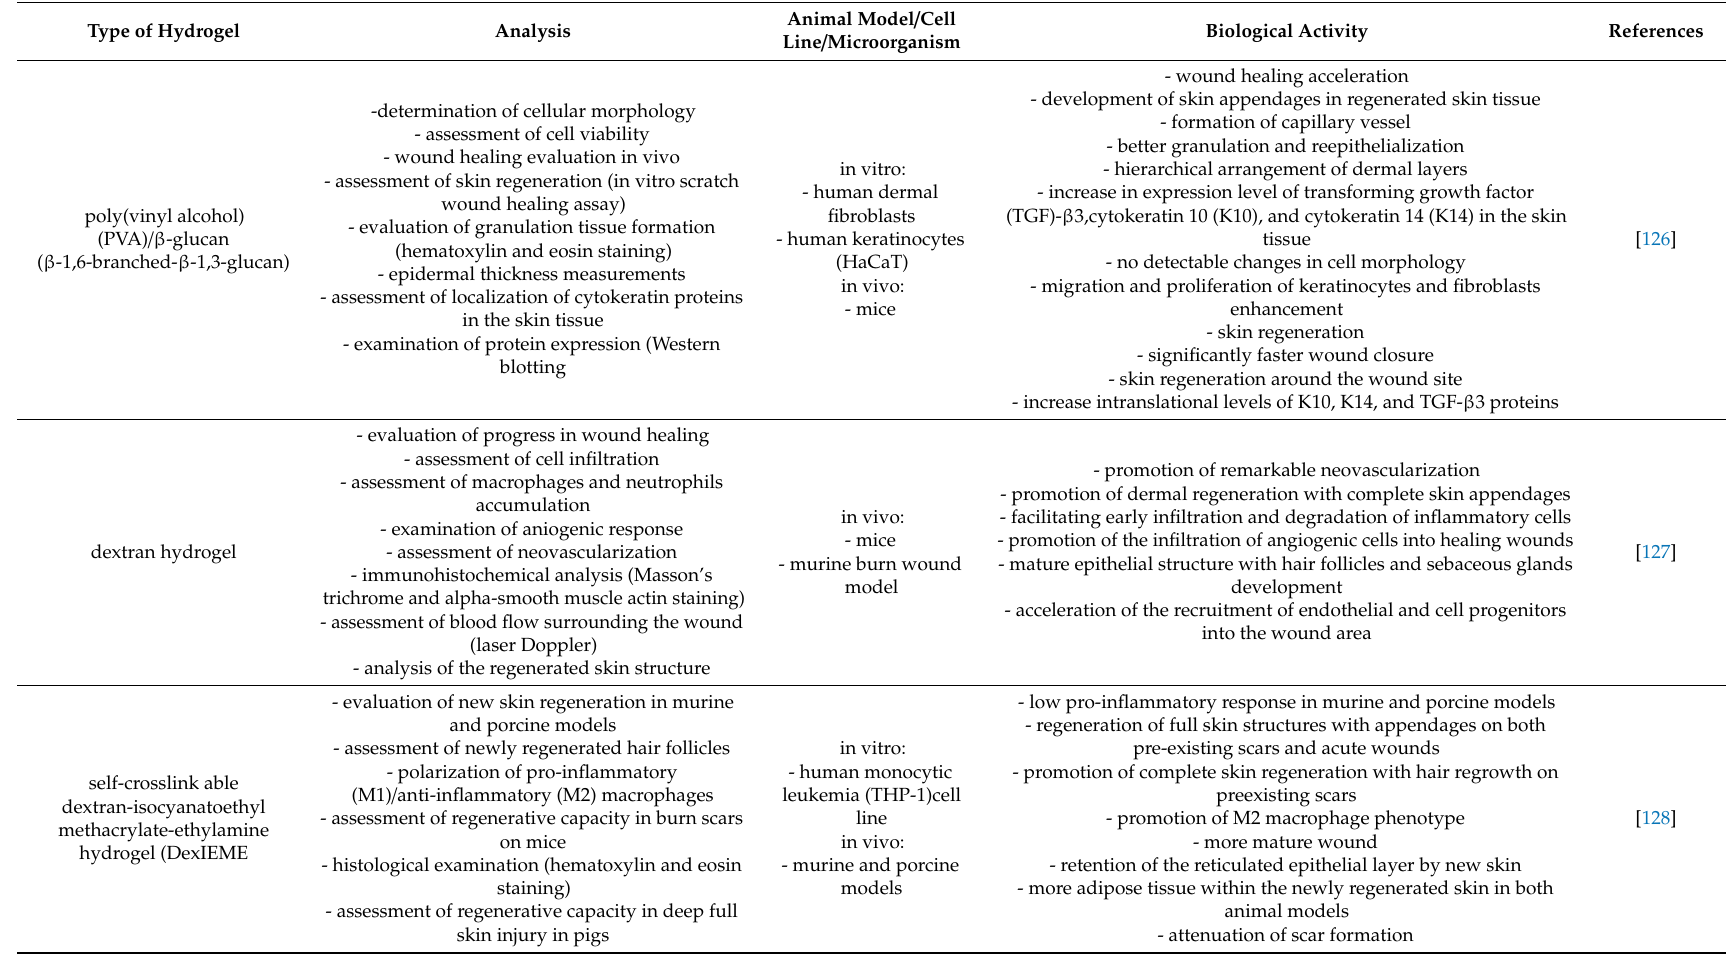
Table 2. Hydrogels for wound healing